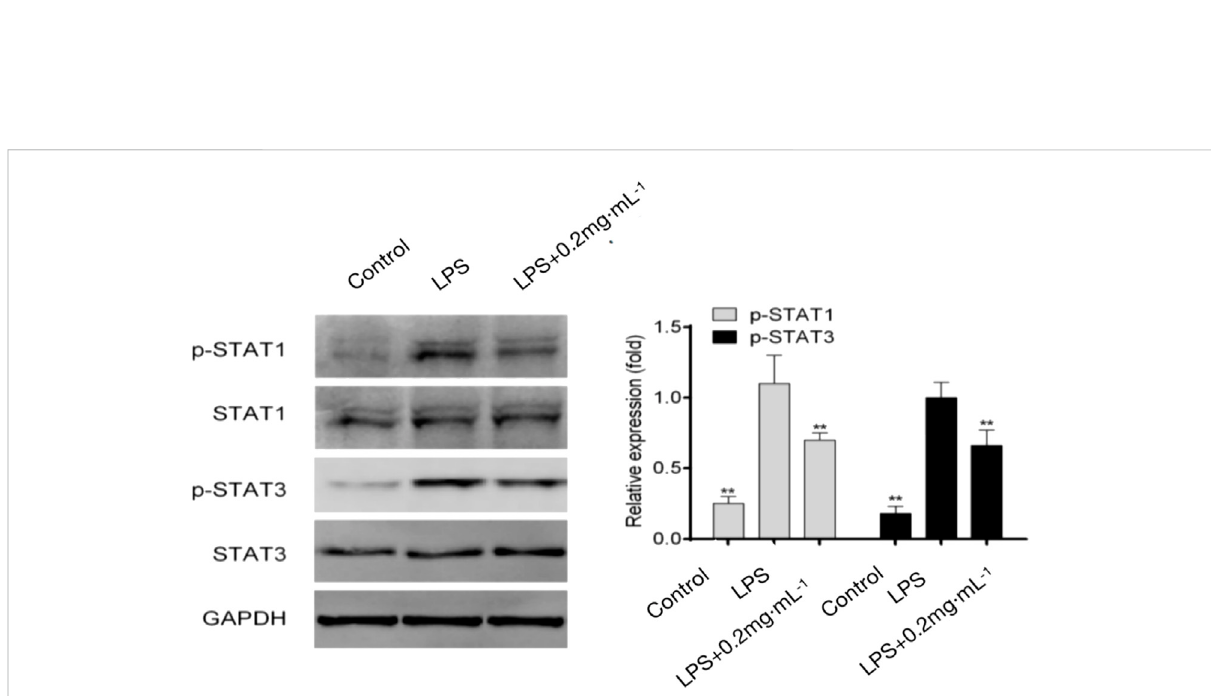
FIGURE 6 Effect of DF on Th-related STAT proteins. **, p < 0.05, compared with model group.